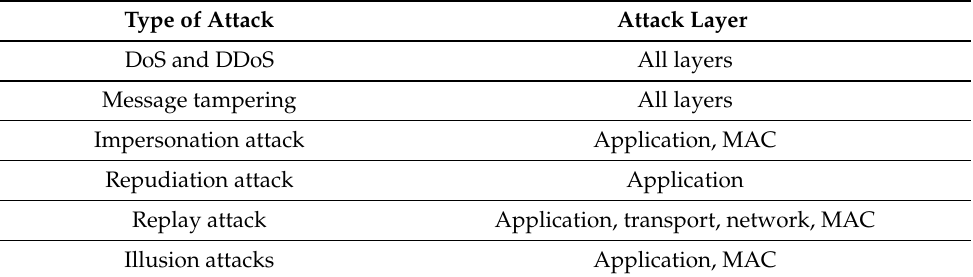
Table 3. Specific and common attacks on VANET